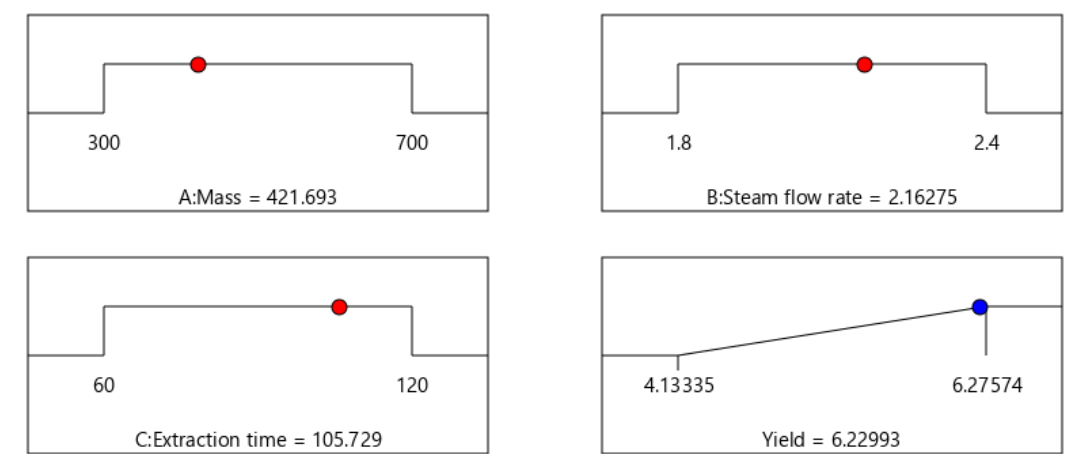
Figure 5. Optimal conditions obtained from RSM. Where, the red point is the value of the influencing variables and the blue point is the value of the objective function which is the optimal condition of the extraction